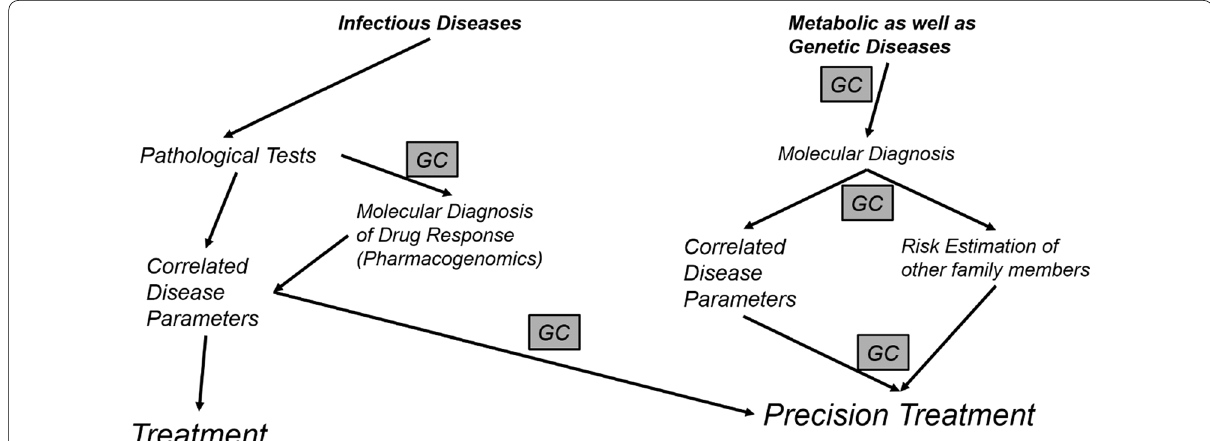
Fig. 1 Flowchart showing the utility of Genetic Counseling (GC)-based diagnosis to the patients provide precision treatment in comparison to commonly practiced